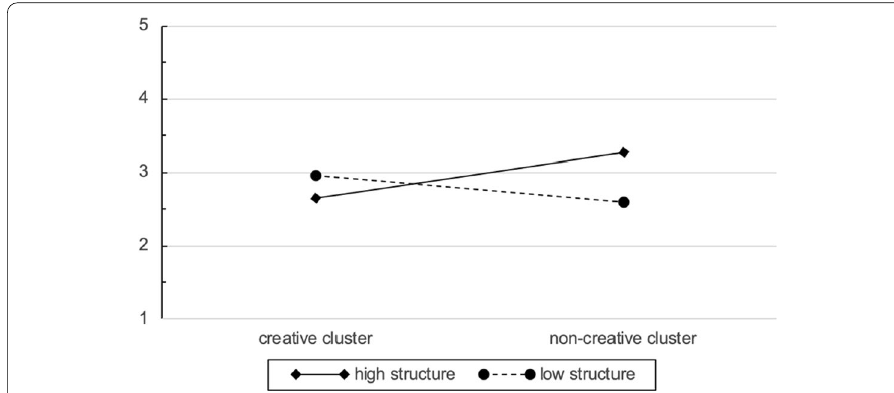
Fig. 4 Interaction effect of creativity_cluster*group for situational